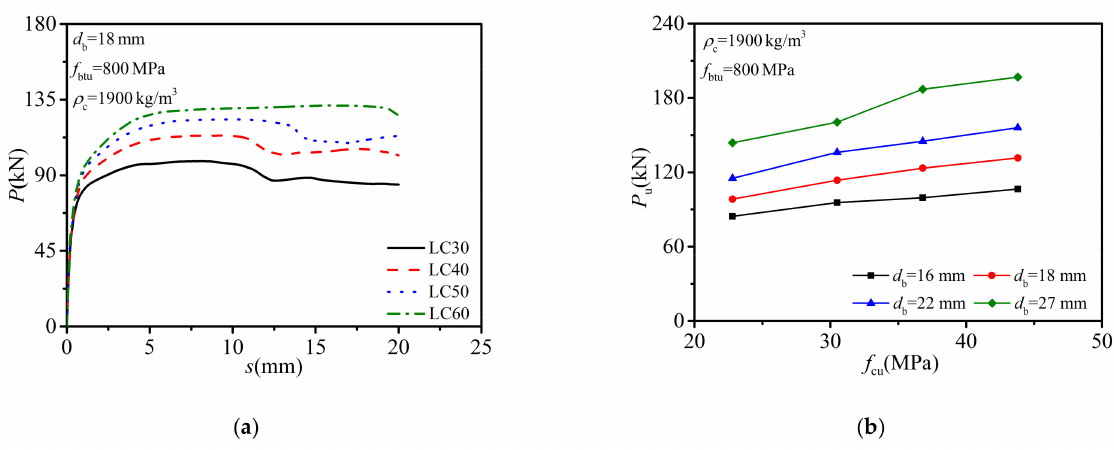
Figure 14. Influence of concrete strength ( f cu ): ( a ) force-slip relationship; ( b ) shear